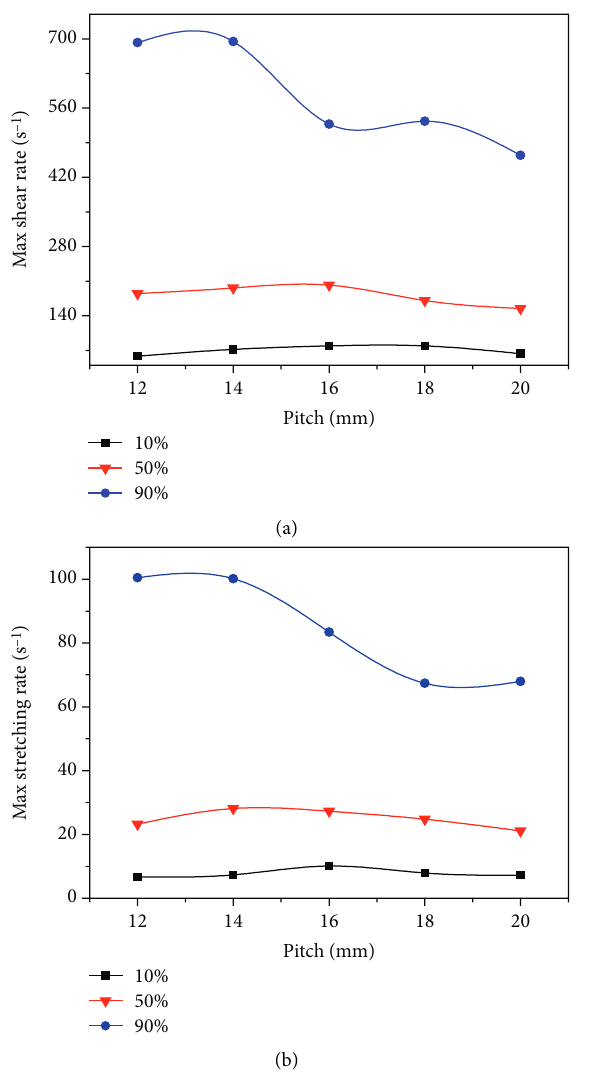
Figure 14: Influence of rotor pitch on the maximum time averaged efficiency (a) and mixing index